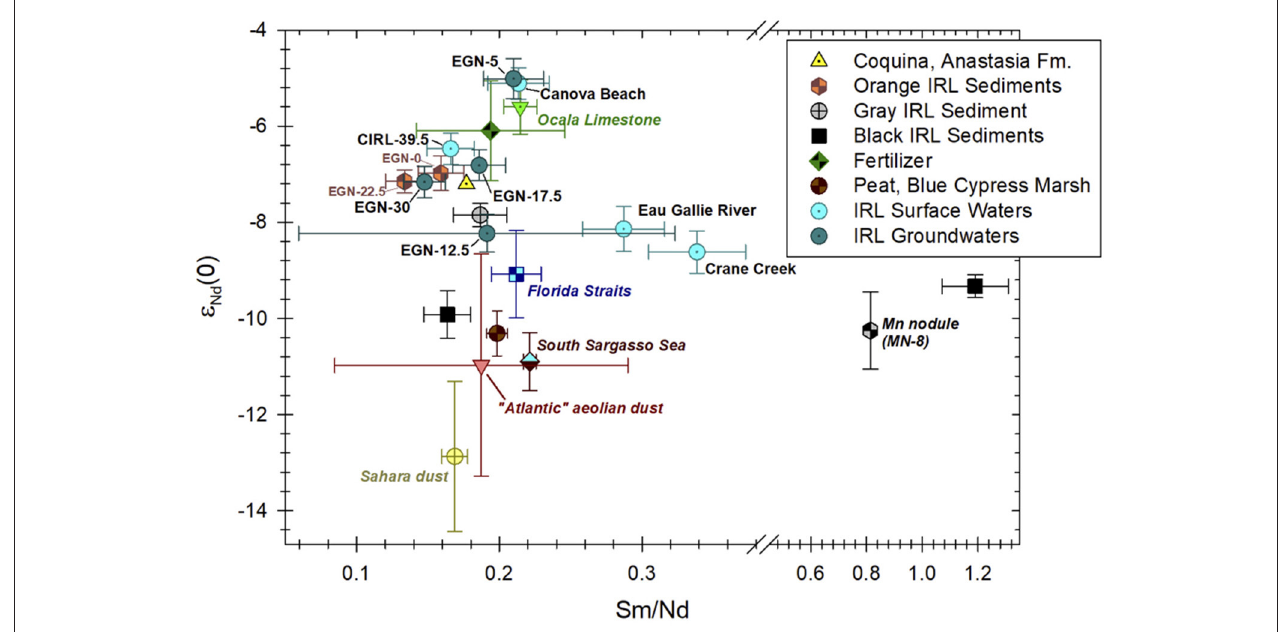
FIGURE 6 | ε Nd (0) values vs. Sm/Nd for Indian river Lagoon (IRL) surface waters, groundwaters, and sediments collected from the IRL subterranean estuary. Sediment samples from the subterranean estuary are color coded to match their observed colors during sample collection [e.g., see Figure 2 from Roy et al. (2011)]. The large ± 1 σ range for the Sm/Nd ratio shown for groundwater sample ENG-12.5 reflects the fact that the Nd and Sm values used to compute the ratio for this sample are based on the averages of four groundwater samples from the two closest multisamplers (see Table 1 ). Neodymium isotope composition of Indian River Lagoon sediments analyzed in this contribution are labeled “Orange IRL Sediments” from the Fe production zone (EGN-0, 205–207 cmbsf and EGN-22.5, 185–187 cmbsf), “Gray IRL Sediment” from the portion of the Fe sink zone where Fe is re-adsorbed to the sediments (EGN-22.5, 50–52 cmbsf), and “Black IRL Sediments” where Fe sulfide minerals precipitate within the Fe sink zone (EGN-22.5, 2–4 cmbsf, and CIRL-39, 5–7 cmbsf; Table 2 ). Neodymium isotope data and REE contents for the Ocala Limestone, coquina from the Anastasia Formation, and peat from Blue Cypress Marsh in Florida are from Kamenov et al. (2009). Note, the ε Nd (0) values and Sm/Nd ratio for the Anastasia Formation coquina reflects the Fe(III) oxide/oxyhydroxide coatings on these materials (G. D. Kamenov, 2021, pers. comm.). Fertilizer data are from Martin and McCulloch (1999), Aubert et al. (2002), and Douglas et al. (2012), whereas the Mn nodule (MN-8) data are from the Blake Plateau to the east of the Florida-Hatteras Slope about 285km due east of Sapelo Island, Georgia (Piepgras et al., 1979). The data for the “Atlantic” aeolian dust and Sahara dust are from Goldstein et al. (1984) and Grousset et al. (1998), respectively. The South Sargasso Sea and Florida Straits data are the same as shown in Figure 2